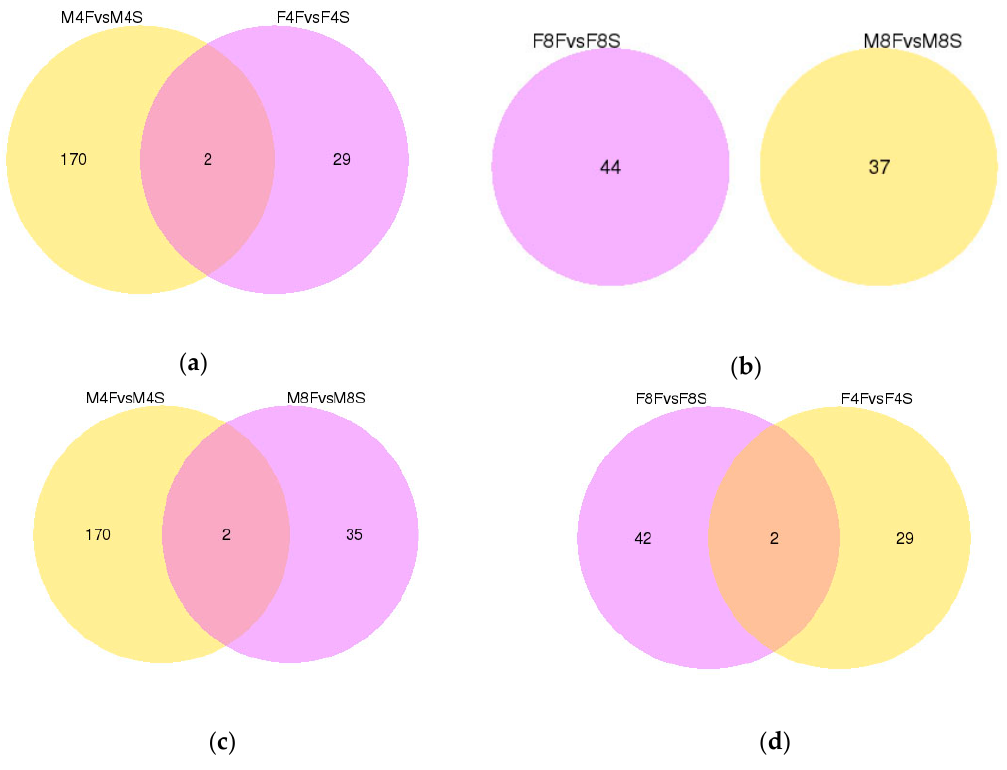
Figure 2. Venn diagram of di ff erentially expressed genes. ( a ) Venn diagram of di ff erentially expressed genes for four-week old males and females. ( b ) Venn diagram of di ff erentially expressed genes for eight-week old males and females. ( c ) Venn diagram of di ff erentially expressed genes for four-week and eight-week-old males. ( d ) Venn diagram of di ff erentially expressed genes for four-week and eight-week-old females.